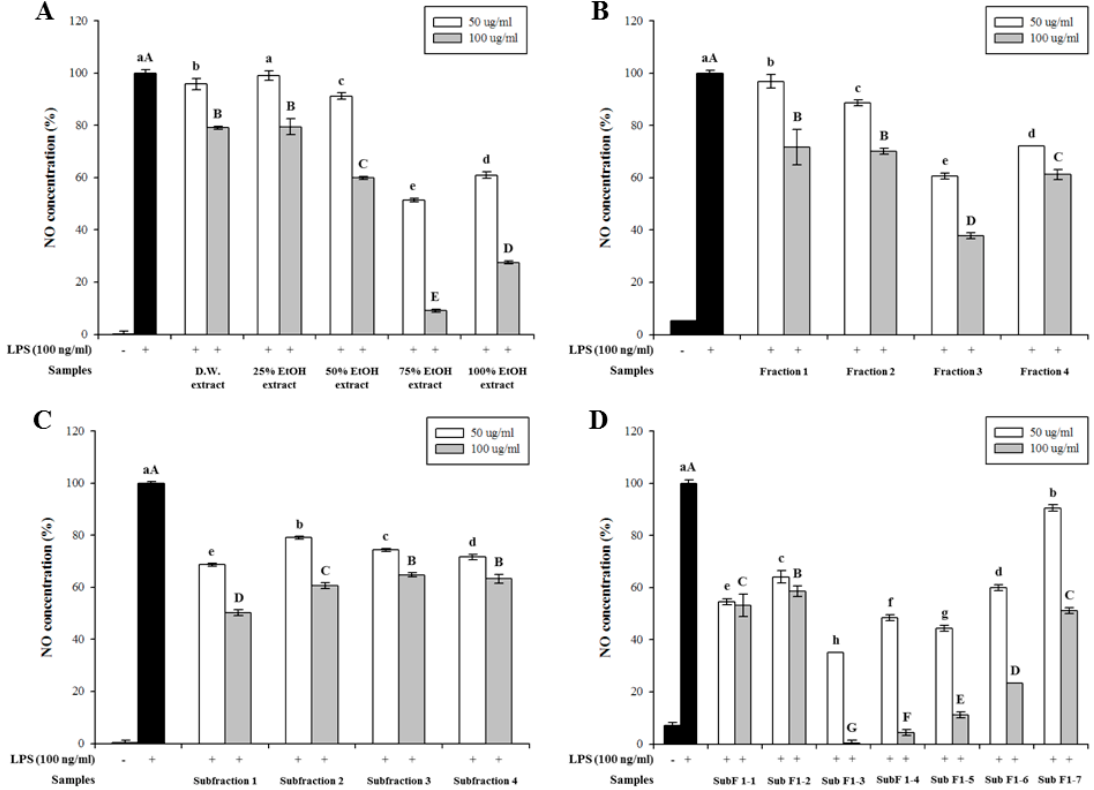
Figure 1. Effect of Actinidia arguta (Actinidiaceae) leaves extracts and the fractions obtained from the 75% ethanol extract, prepared using preparative liquid chromatography (prep-LC) on nitric oxide (NO) production in lipopolysaccharide (LPS)-induced RAW 264.7 cell. Cells were treated with 100 ng/mL of LPS and samples (50 and 100 µ g/mL) for 20 h, and then NO concentration was measured. Values are expressed as a percentage of control (LPS alone). Data are expressed as mean ± SD after triplicate analysis. Different letters indicate significant differences compared with LPS control at p < 0.05. ( A ) A. arguta extracts. ( B ) Fractions from the 75% ethanol extract of A. arguta leaves. ( C ) Sub-fractions from fraction 3. ( D ) Fractions from sub-fraction 1.